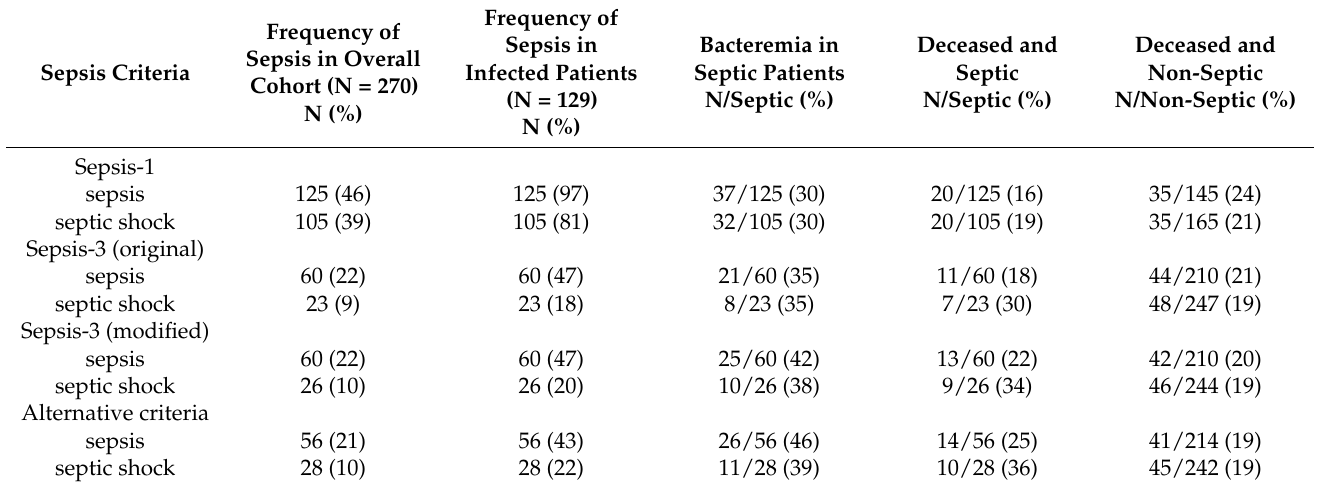
Table 5. Frequency of sepsis and septic shock according to different criteria, associated bacteremia, and